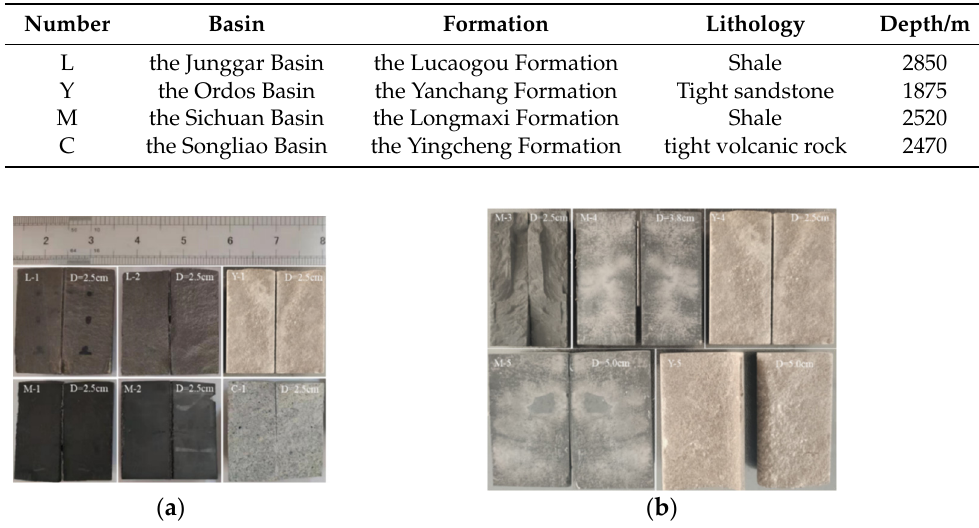
Figure 2. Representative samples used in experiments. ( a ) Samples with a diameter of 2.5 cm; ( b ) samples with a diameter of 2.5 cm, 3.8 cm, and 5 cm.